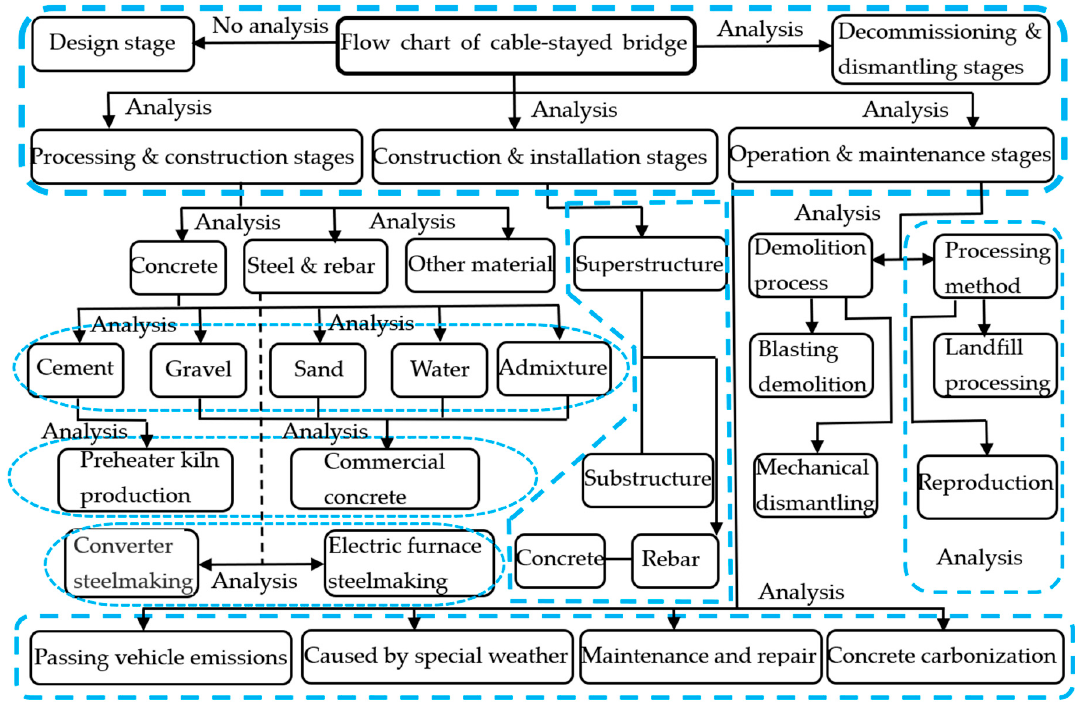
Figure 1. Life-cycle assessment (LCA) analysis flow chart of the three-tower cable-stayed bridge.